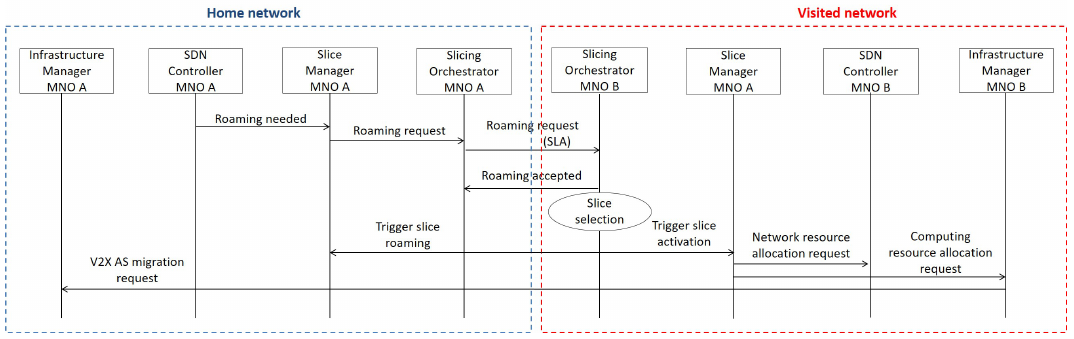
Figure 4. Main required interactions for the roaming